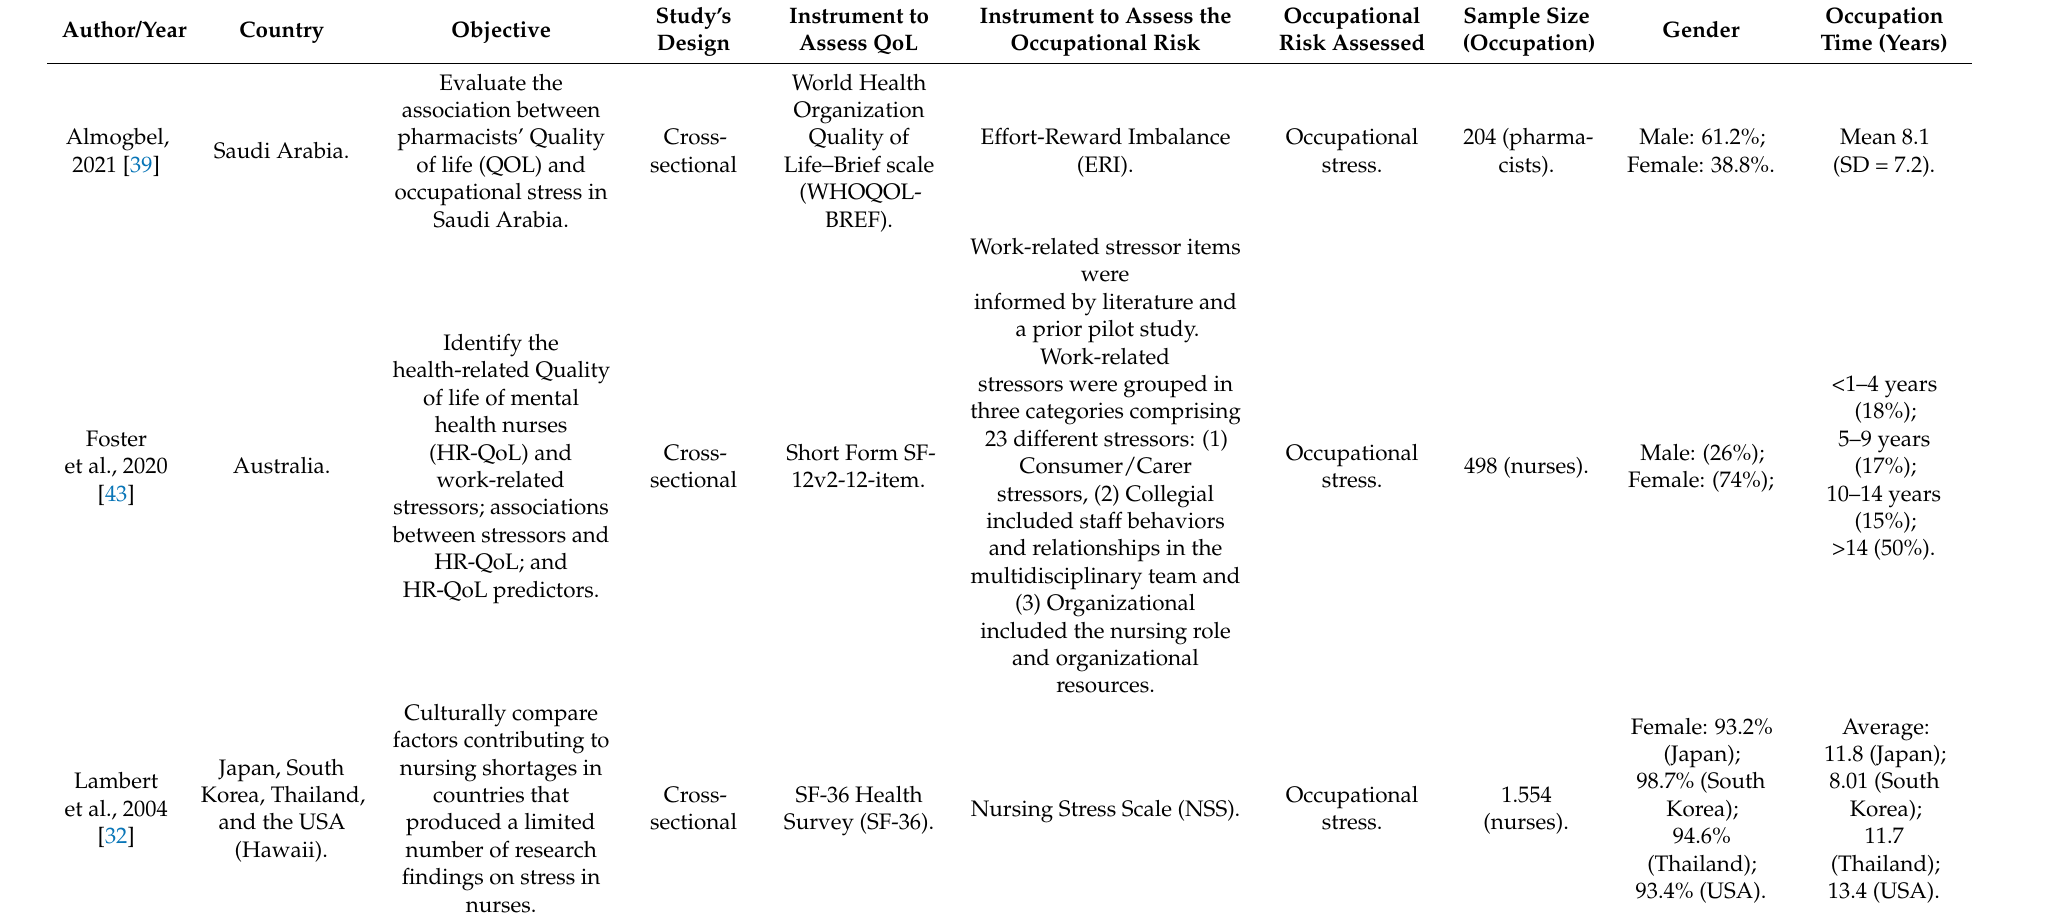
Table 1. Summary of the findings in the documents included in the review regarding quality of life